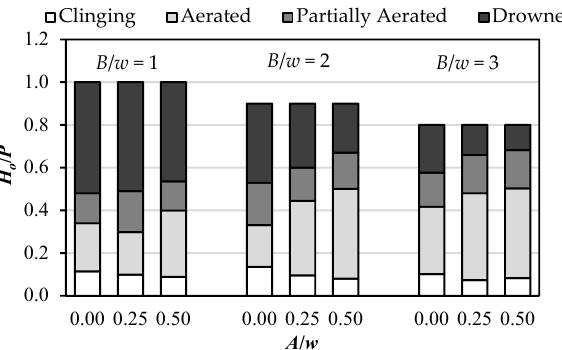
Figure 15. Variations of flow aeration regime with H o / P , A / w , and B / w . According to Figure 15, when B / w = 3 and A / w = 0, the thresholds of the partially aerated and drowned regimes are H o / P = 0.42 and 0.58, respectively. The corresponding values were reported as 0.29 and 0.39 by Crookston and Tullis (2013) for a labyrinth weir with relatively similar dimensionless parameters ( B / w = 2.8 and A / w = 0.06) [42].